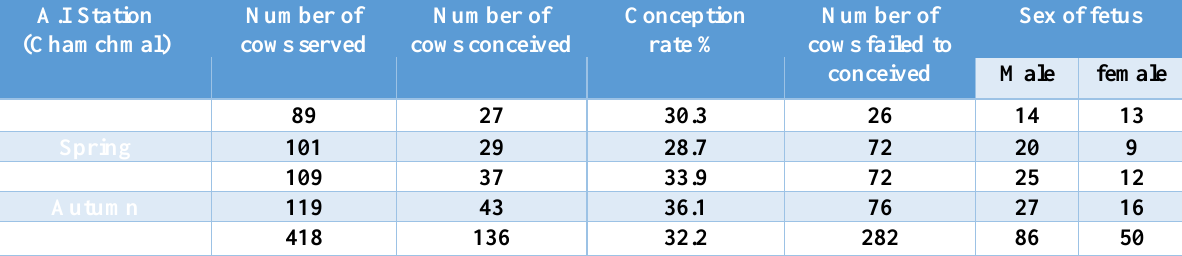
Figure, 4: Histogram the conception rate of cows and sex of cale in different seasons in different seasons for Rania station. Table, 5: The conception rate of cows and sex of the calf in different seasons for Chamchamal